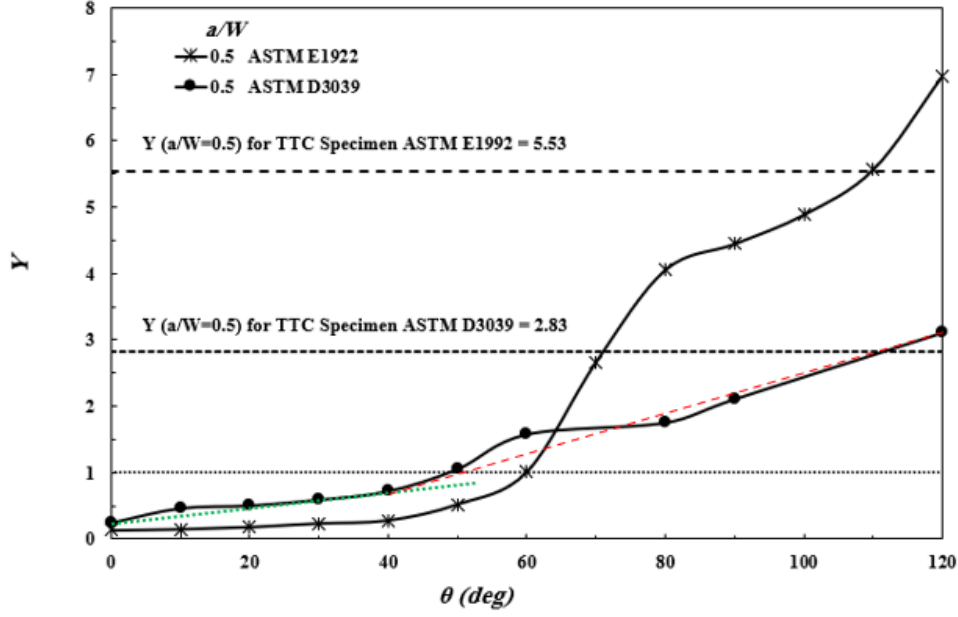
Figure 15. The geometry correction factor ( Y ) of MC ASTM E1922 and ASTM D3039 specimens with a/W = 0.5 and different debonding angles ( θ ).